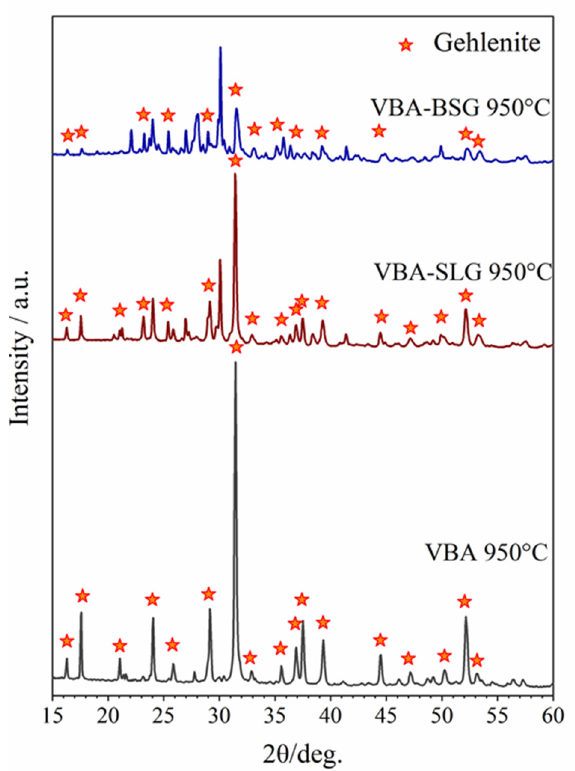
Figure 3. Decrease of gehlenite diffraction peaks, at 950 °C, caused by the addition of SLG and BSG glass.